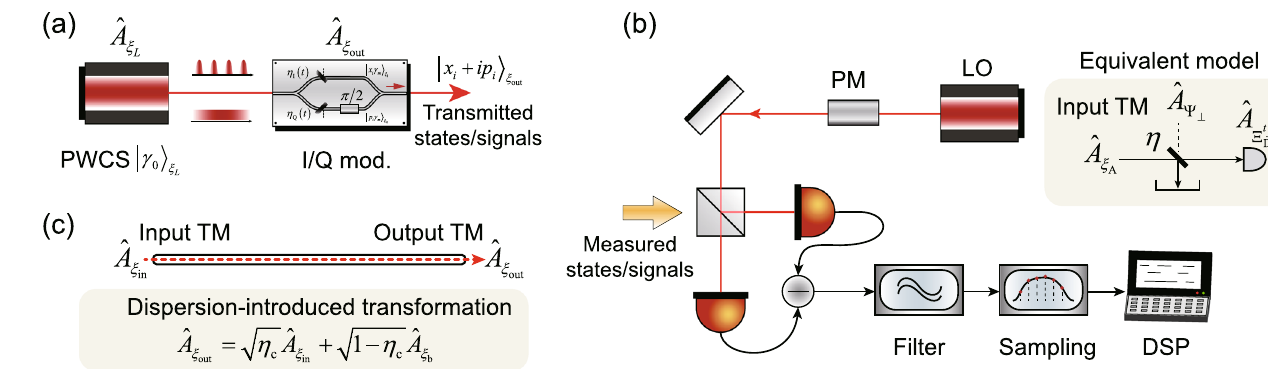
Fig. 1 Models of digital CVQKD. a The transmitter prepares a photon-wavepacket coherent state (PWCS) with an arbitrary form of envelope ξ L t ð Þ ; via the I/Q modulation, the quadratures of the PWCS are modulated by Gaussian distributed random numbers. The carrier can be either a continuous wave or pulsed coherent state. b Measured states are fed to a practical receiver, interfering with the local oscillator (LO) at a balanced beam splitter (BS) and detected by a band-limited homodyne detector (HD) (modeled by an ideal HD and a fi lter), followed by the sampling and DSP devices. The mismatch between the measured state ’ s temporal mode (TM) and the receiver ’ s TM is equivalent to a BS with a transmitivity of η . c In the experiment, channel transmission causes a transformation of TM, which, if ignored, will cause a degradation in system performance. PM phase